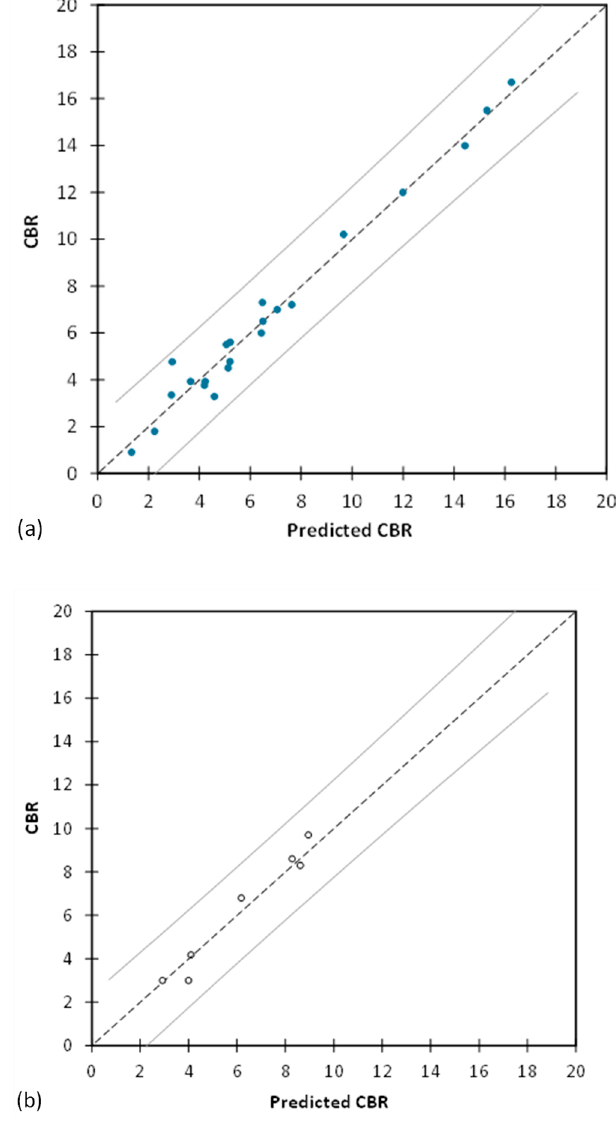
Figure 7. The results of the best SVM model predicting CBR values for the ( a ) training and ( b ) test- ing